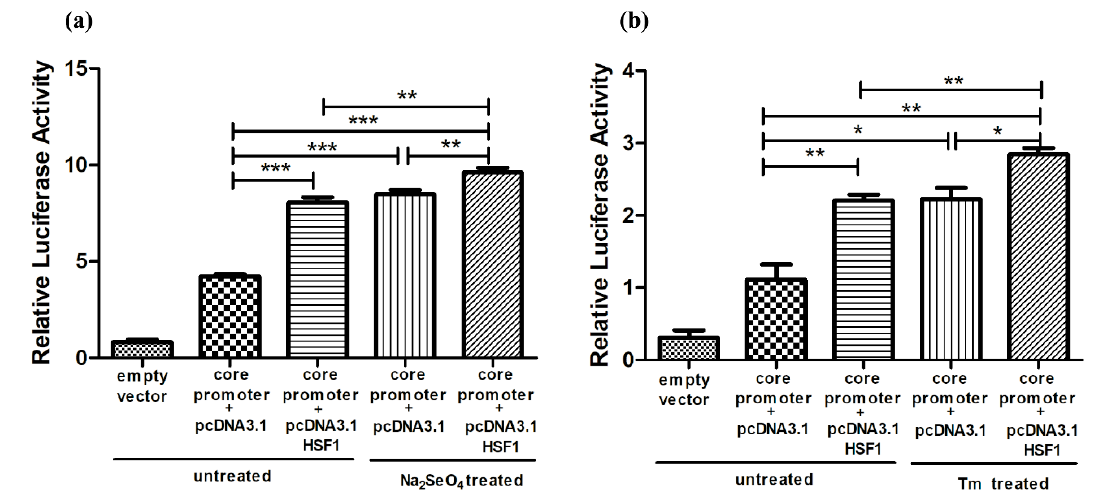
Figure 7. HSF1 further increased SELENOF transcriptional regulation during selenate and Tm treatment. Luciferase reporter activities of SELENOF core positive regulatory element in control and HSF1 over-expressed HEK293T cells with / without ( a ) selenate and ( b ) Tm treatment. * p < 0.05, ** p < 0.01 and *** p < 0.001.